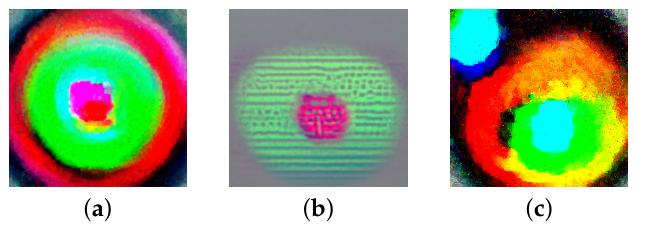
Figure 8. Different types of adversarial patches: ( a ) strong adversarial patch generated by YOLOv3; ( b ) weak adversarial patch generated by YOLOv3; ( c ) strong adversarial patch generated by